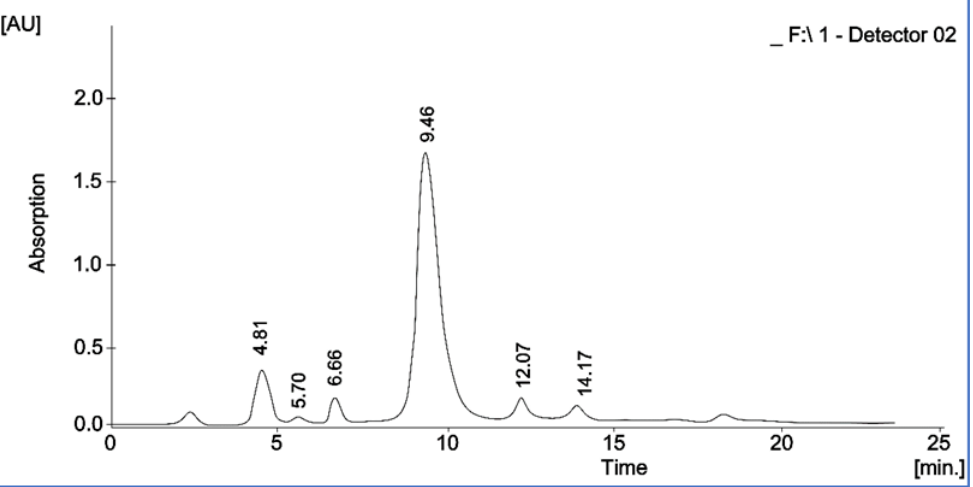
Figure 1. HPLC chromatogram representing the tocopherol content in the aqueous extract of okra pods.